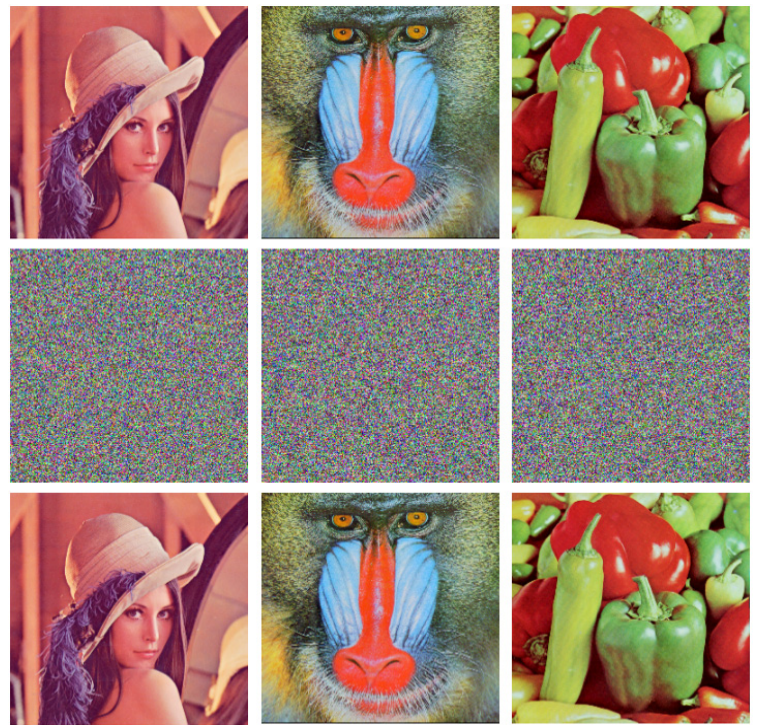
Figure 20. Result of the encryption/decryption using the proposed methods.